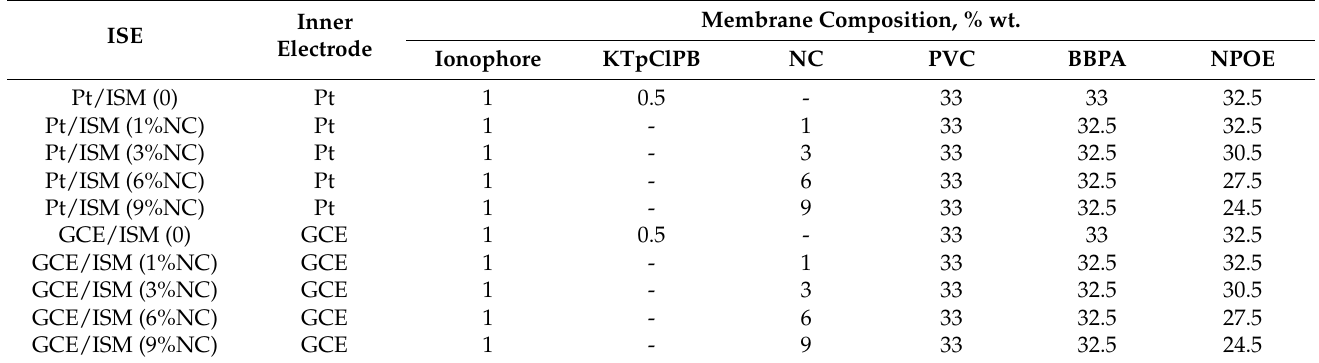
Table 1. Types of tested electrodes and the composition of their